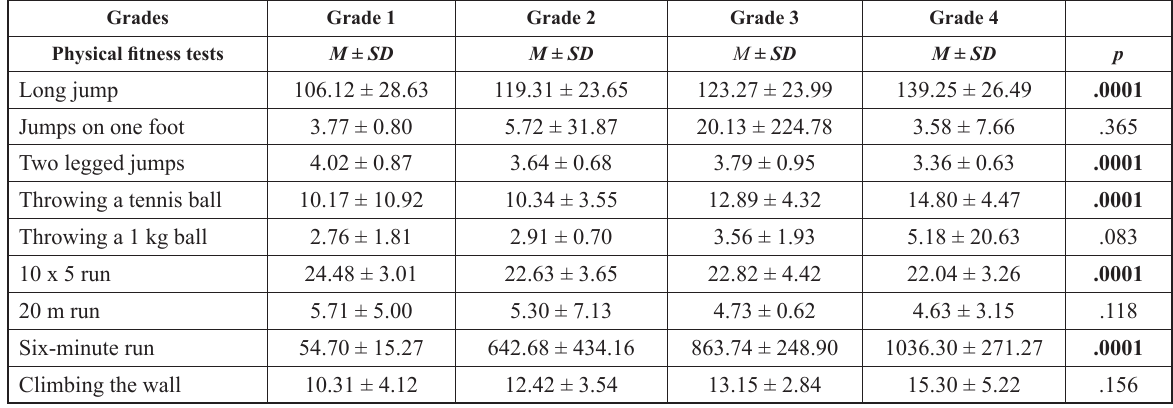
Table 3. Distribution of schoolchildren’s physical fitness assessment mean results by grade Grades